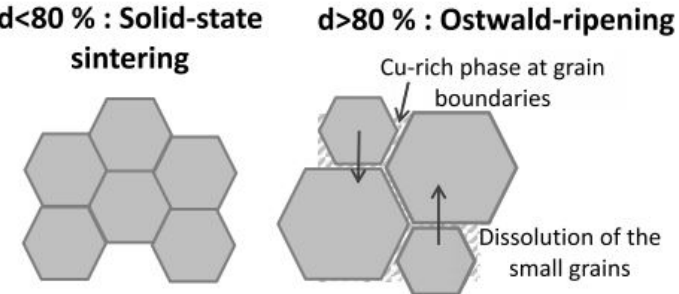
Figure 7. Proposed scheme of grain growth mechanism reported by Guillaume Riquet et.al [39].